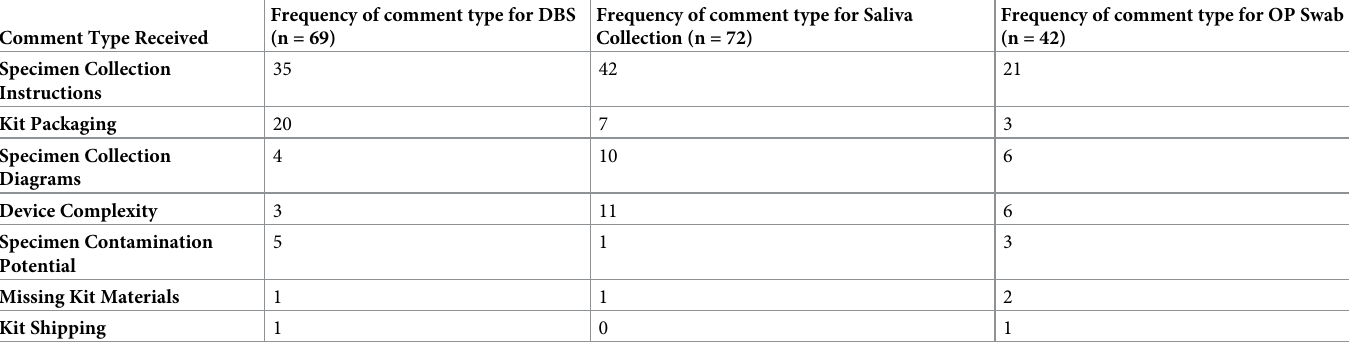
Table 3. Frequency of themes from participants after self-collecting saliva, oropharyngeal swabs and dried blood spot cards for SARS-CoV-2-related testing, United States, April